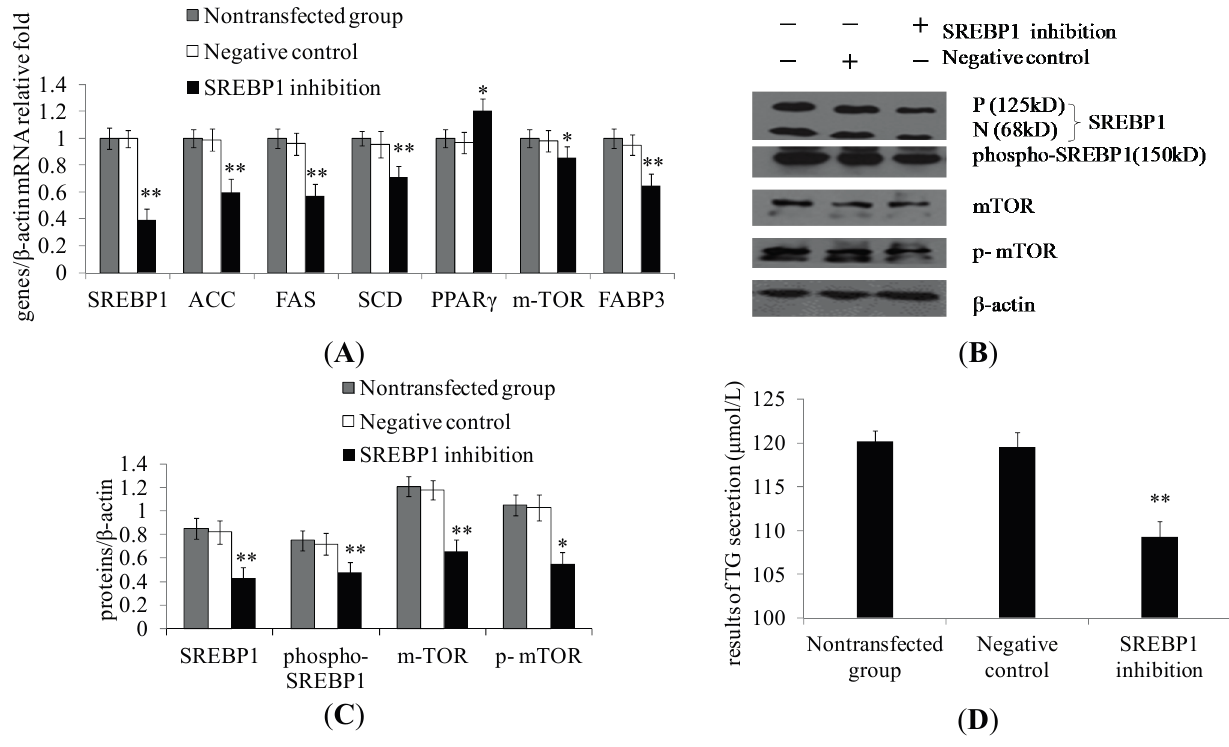
Figure 2. Effect of SREBP1 gene silencing on milk fat synthesis in DCMECs. Three groups of DCMECs were assessed: nontransfected group, negative group (control group), SREBP1 siRNA-transfected group. ( A ) Relative mRNA levels (gene of interest/ β -actin) of indicated genes were determined by qRT-PCR after gene silencing of SREBP1 ; ( B ) Expression levels of indicated proteins were assessed by Western blotting. P and N denote the precursor and cleaved nuclear forms of SREBP1, respectively; ( C ) Quantification of protein of interest/ β -actin relative fold by gray scale scan; and ( D ) TG content in the culture supernatant of DCMECs. Values represent means ± SE ( n = 3). * p < 0.05, ** p < 0.01 compared with negative control